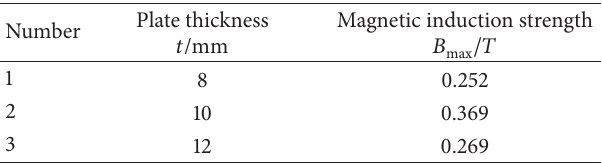
Table 3: Simulated results of magnetic induction strength for different plate thickness.